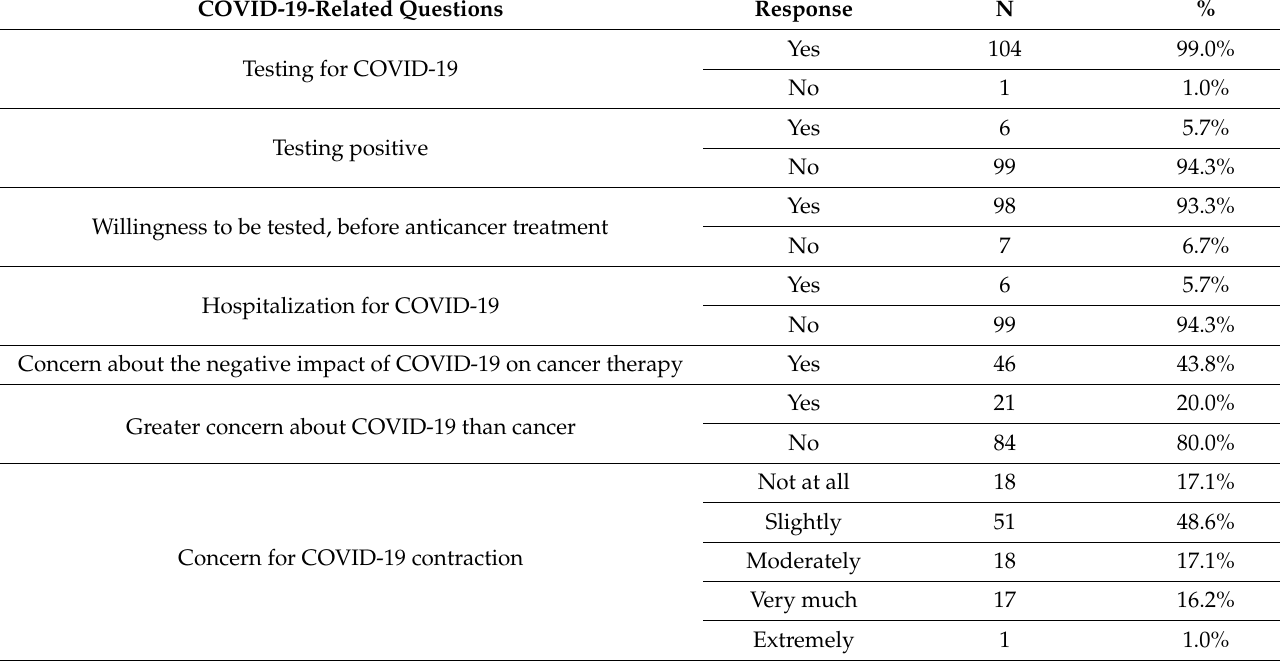
Table 2. Responsiveness to items related to the COVID-19